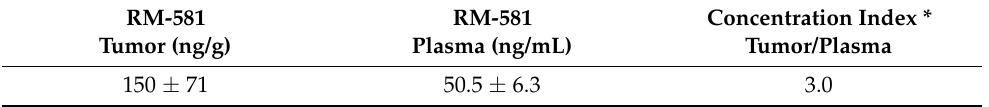
Table 1. Tumor and plasma concentrations of RM-581 from xenograft experiments as determined by LC-MS/MS at the end of the protocol (3 h post-treatment).